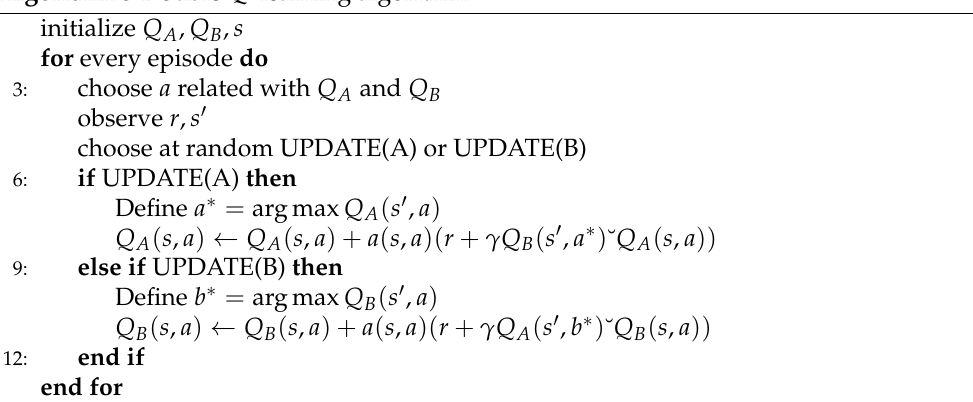
Algorithm 3 Double Q–learning